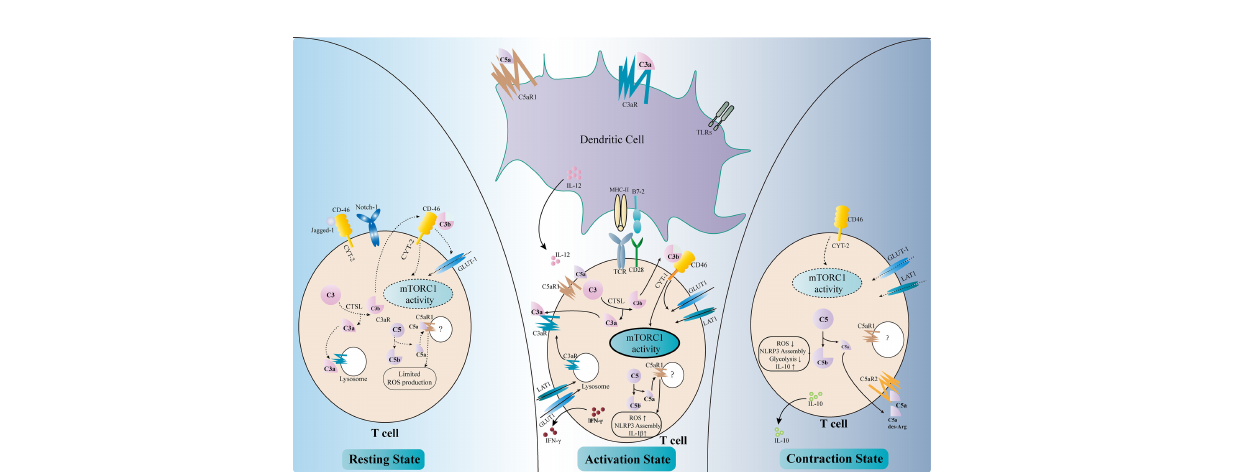
FIGURE 3 | Regulation of T-cell activity by complement components. Complement factors modulate T-cell activation either directly or indirectly ( middle part of the fi gure ). C3aR and C5aR1 are expressed on dendritic cells (DCs). The binding of C3a and C5a, together with Toll-like receptor (TLR) signals, upregulates the expressions of MHC II, B7-2, and IL-12 and enhances the antigen presentation activity of DCs. The intracellular complement system directly regulates T-cell activity. The activation of T-cell receptors (TCRs) and co-stimulatory receptors leads to the intracellular cleavage of C3 by cathepsin L (CTSL). C3a and the C3aR transported from the lysosome to the cell surface reinforce C3a – C3aR signaling in T cells. C3b binds to CD46 – CYT-1 and upregulates the nutrient transporters such as GLUT1 and LAT1. The activation of CD46 – CYT-1 also enhances the activity of mTORC1, which modulates the cellular metabolism activity and promotes Th1 response. Intracellular C5a – C5aR1 signaling increases the reactive oxygen species (ROS) level in the mitochondria, therefore promoting the assembly of the NLRP3 in fl ammasome and the production of IL-1 b . These changes lead to the production of IFN- g necessary for Th1 response. Complement also regulates T- cell homeostasis ( left part of the fi gure ). In resting T cells, tonic intracellular cleavage of C3 by CTSL produces C3a and C3b. C3a binds to C3aR on lysosomes, while C3b binds to CD46 – CYT-2 on the cell surface. The latter sustains a limited mTORC1 activity and the expression of GLUT-1. Intracellular C5a – C5aR1 signaling also produces limited amounts of ROS necessary for T-cell survival. In addition, CD46 could bind to Jagged-1, therefore inhibiting the Notch-1 signaling required for T-cell activation. In the contraction phase after T-cell activation ( right part of the fi gure ), CD46 adopts the CYT-2 isoform, identical with the resting state. This leads to decreased mTORC1 activity and declined expressions of the nutrient transporters. Instead of binding to intracellular C5aR1, C5a and its derivative C5a-desArg are secreted to the extracellular space and bind to C5aR2 on the cell surface, therefore inhibiting intracellular C5a – C5aR1 signaling. These changes result in decreased ROS production and NLRP3 activity, as well as elevated IL-10